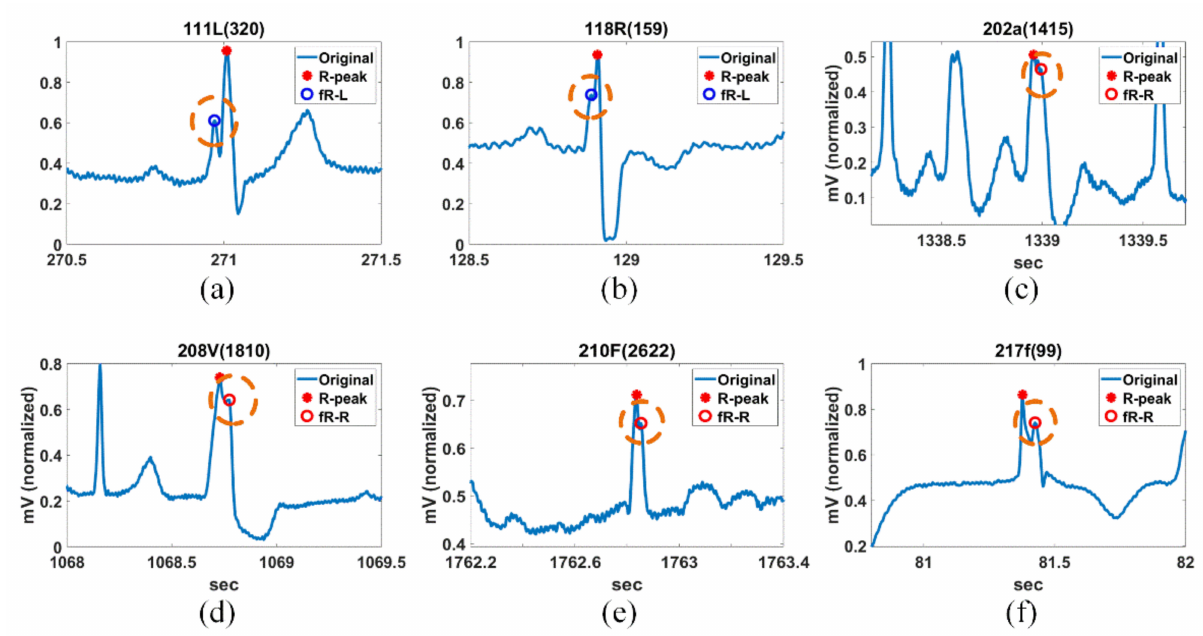
Figure 7. Detection of the R-peak and additional R-peak for ( a ) 111L(320), ( b ) 118R(159), ( c ) 202a(1415), ( d ) 208V(1810), ( e ) 210F(2622), and ( f ) 217f(99) in MIT-DB.